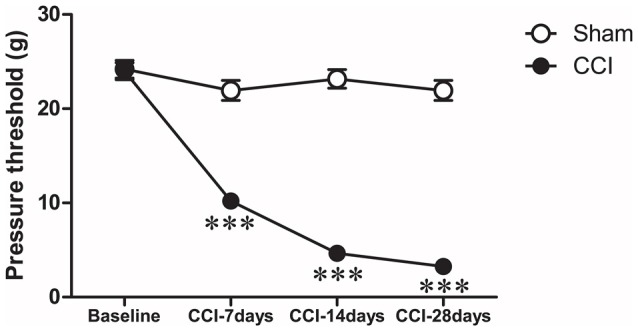
Time-course changes in paw withdrawal threshold after CCI. Ipsilateral paw withdrawal threshold (g) in response to paw-pressure stimulation: ***P < 0.001 vs. baseline (Day-1) by repeated measures, two-way ANOVA, followed by Tukey-Kramer honest significant difference post-test.